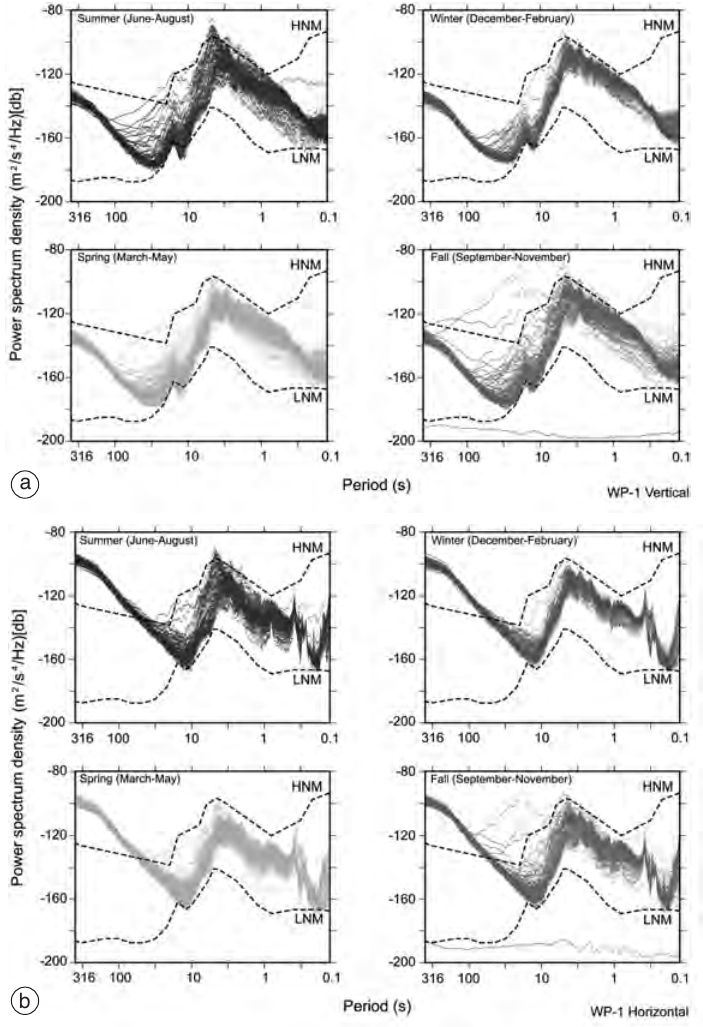
Fig. 8a,b. Power spectra of the deep-sea borehole seismic observatories. Power spectra estimated using one- hour records for the all observation period are plotted. HNM and LNM indicate the high noise model and the low noise model by Peterson (1993), respectively. The power spectra are grouped by seasons: a) for vertical com- ponent of WP-1; b) for horizontal component of WP-1. The horizontal component records of the WP-1 Obser- vatory have larger noises in periods longer than 20 s. The records of the WP-1 have larger noise levels near a few seconds period in